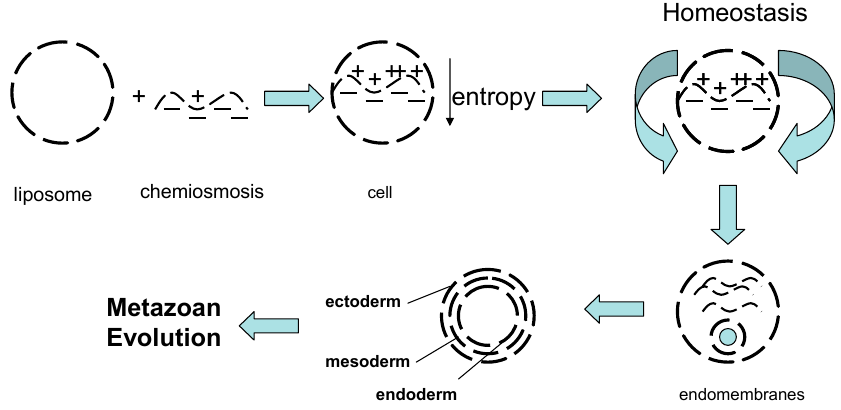
Figure 1. On the evolution of form and function. Starting with the formation of micelles and chemiosmosis, life began as the reduction in entropy, maintained by homeostasis. The generation of endomembranes (nuclear envelope, endoplasmic reticulum, golgi) created intracellular compartments; compartmentation gave rise to the germ lines (ectoderm, mesoderm endoderm) which monitor environmental changes and facilitate cellular Evolution accordingly. This is the basis for “fractal physiology”.